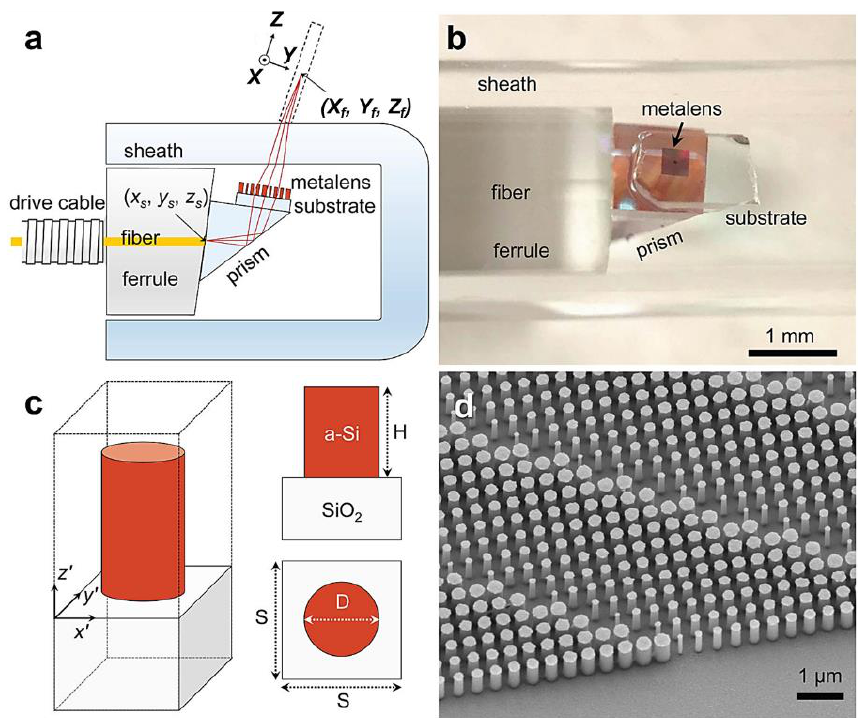
Figure 10. ( a ) Schematic of the nano-optics endoscope. ( b ) Photographic image of the distal end of the nano-optics endoscope. ( c ) Schematic of an individual metalens building block consisting of amorphous silicon (a-Si) nanopillar on a glass substrate. ( d ) SEM image of a portion of a fabricated metalens. Reprinted with permission from Ref. [72]. Copyright 2018 Nature Publishing Group.